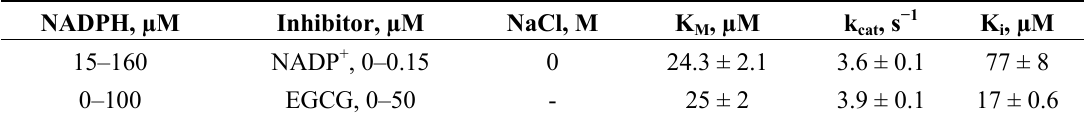
Table 4. Inhibition of the human MICAL-MO NADPH oxidase activity by NADP + and EGCG. Assays were carried out at 25 °C in the presence of the indicated NAD(P)H concentration ranges and additions in 20 mM Hepes/KOH buffer, pH 7.0. Other conditions are as in Table 2. Data are from